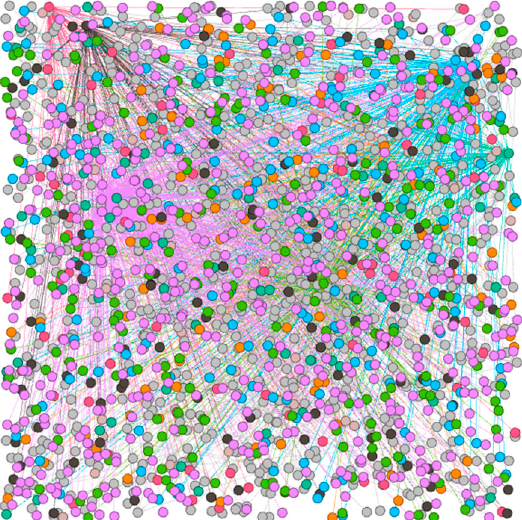
Figure 3. Visualization of the co-authorship of modularity analysis in Gephi.